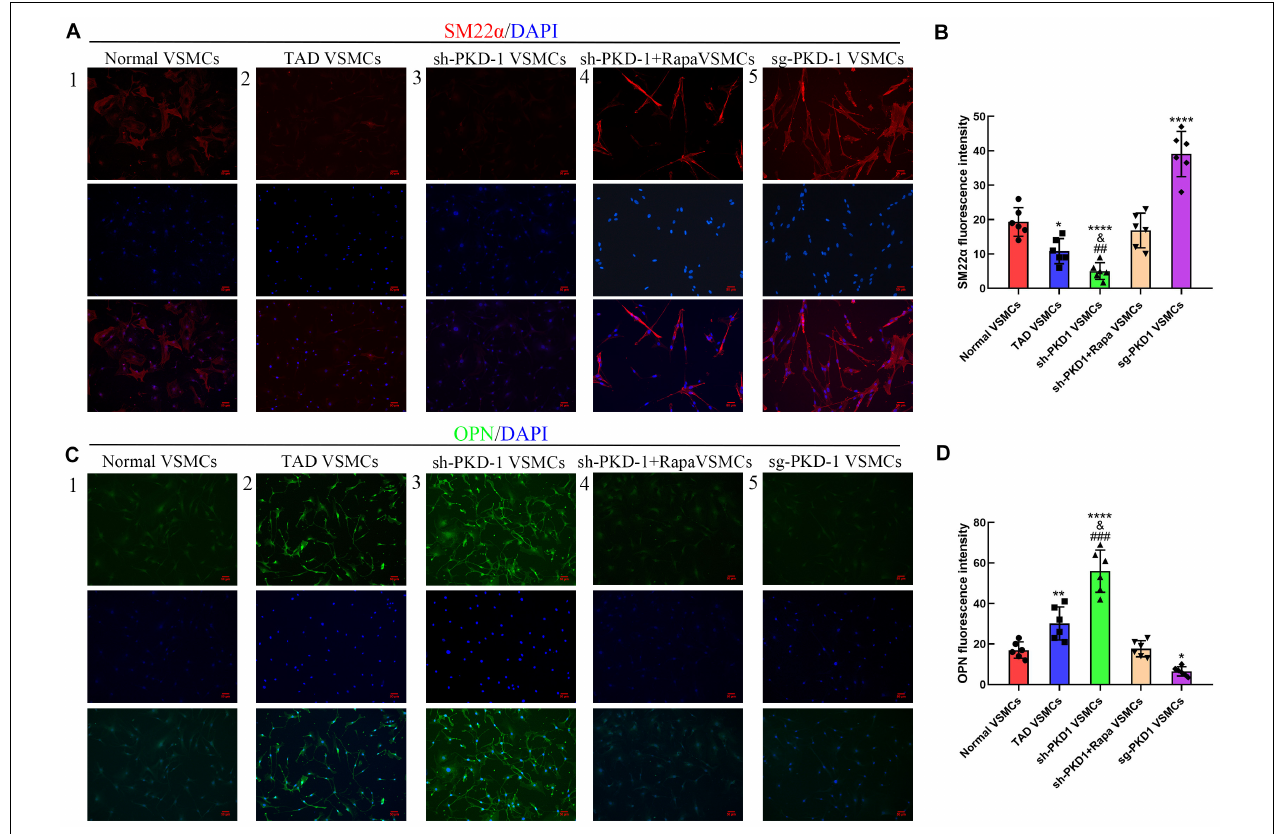
FIGURE 6 | Immunofluorescence of SM22 α and OPN among groups ( n = 6 for each group). (A,B) The fluorescence intensity of SM22 α was decreased in TAD VSMCs ( p = 0.0128) and sh-PKD-1 VSMCs ( p < 0.0001) but enhanced in the sg-PKD-1 group ( p < 0.0001) compared with normal VSMCs. The intensity was increased in sh-PKD-1 VSMCs ( p = 0.0088) compared with the TAD VSMCs, but showed no significance in sh-PKD-1 + Rapa VSMCs compared with normal VSMCs. (C,D) . The fluorescence intensity of OPN was elevated in TAD VSMCs ( p = 0.0064) and sh-PKD-1 VSMCs ( p < 0.0001) and decreased in sg-PKD-1 group ( p = 0.034) compared with normal VSMCs. The intensity was enhanced in sh-PKD-1 VSMCs ( p = 0.0008) compared with the TAD VSMCs, but showed no difference in sh-PKD-1 + Rapa VSMCs compared with normal VSMCs. * p < 0.05, ** p < 0.01, **** p < 0.0001 (compared with normal VSMCs), ## p < 0.01, ### p < 0.001 (compared with TAD